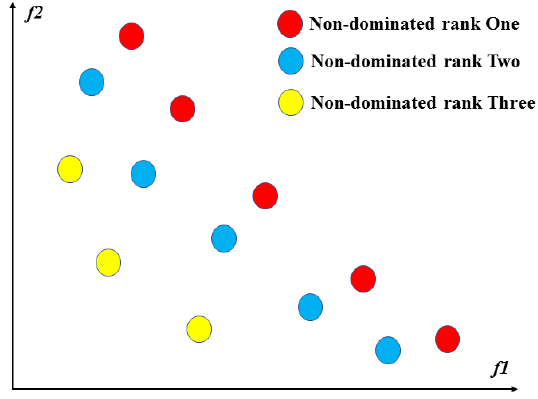
Figure 7. Non-dominated rank.